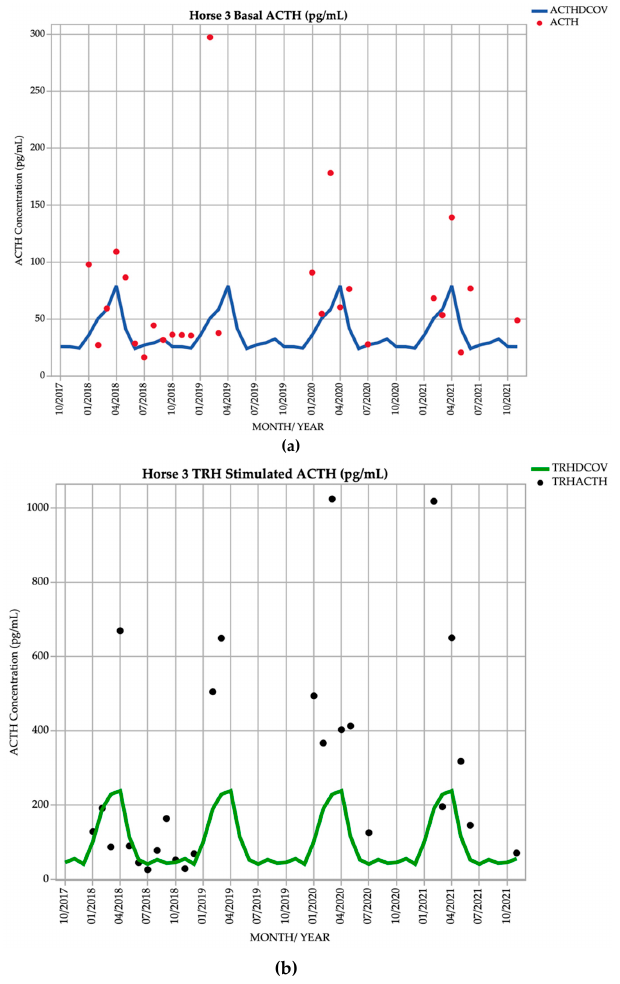
Figure 3. Monthly ACTH concentration (pg/mL) in Horse 3 (12-year-old Standardbred gelding), compared to locally derived, seasonally adjusted DCOV [2]. ( a ) Basal ACTH concentrations (red points) and basal ACTH DCOV (blue line) ( b ) TRH-stimulated ACTH concentrations (black points) and TRH-stimulated ACTH DCOV (green